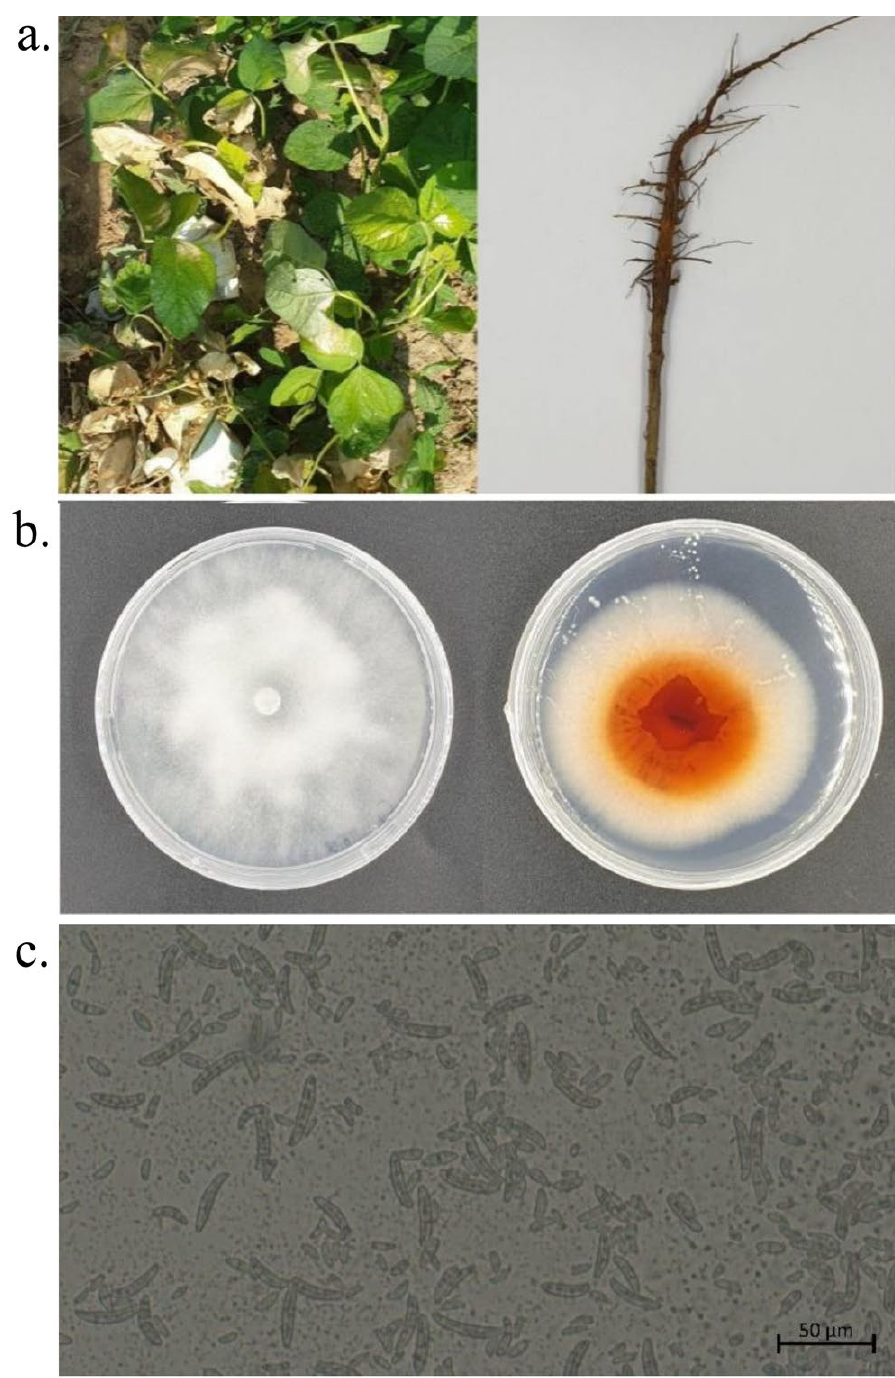
Figure 6. Symptoms of disease in the field and the morphological characteristics of the pathogens (( a ) symptoms in the field; ( b ) colonies of the pathogen isolated from the PDA medium; ( c ) conidia shape under the microscope).